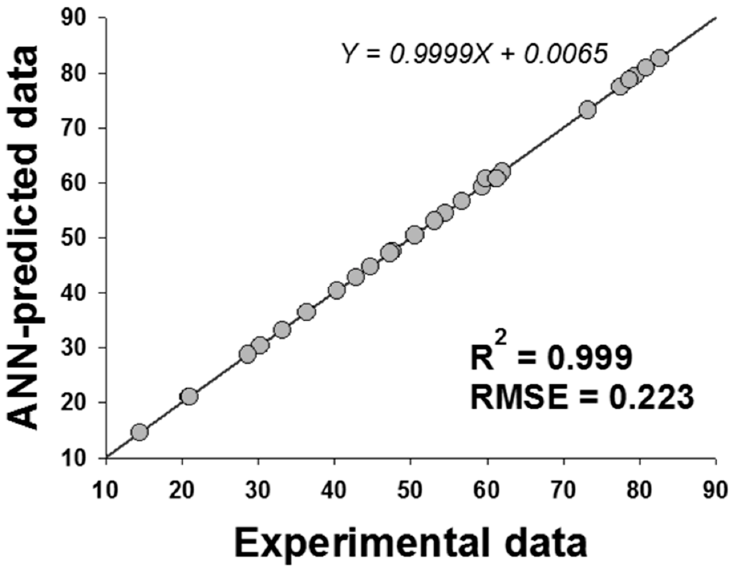
Figure 6. The performance of constructed ANN on data fitting. The ANN performance was evaluated by the coefficient of determination ( R 2 ) and root mean square error ( RMSE ), respectively. Residual values: ANN-predicted values minus experimental values.